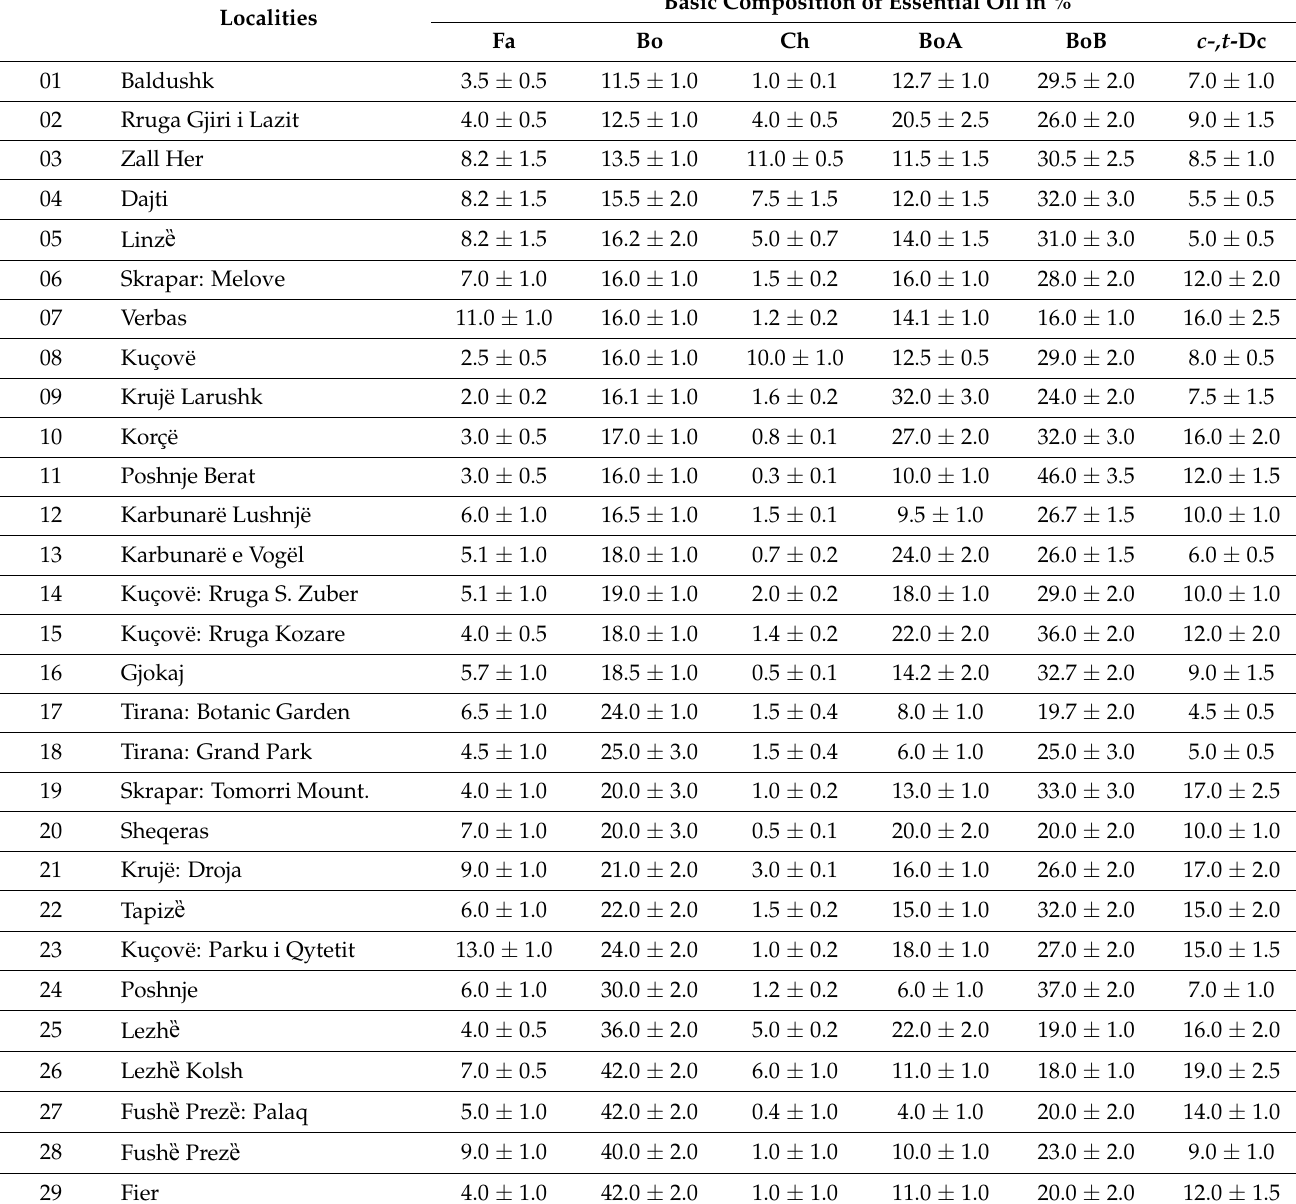
Table 3. Main components of the essential oil isolated from chamomile inflorescences belonging to central